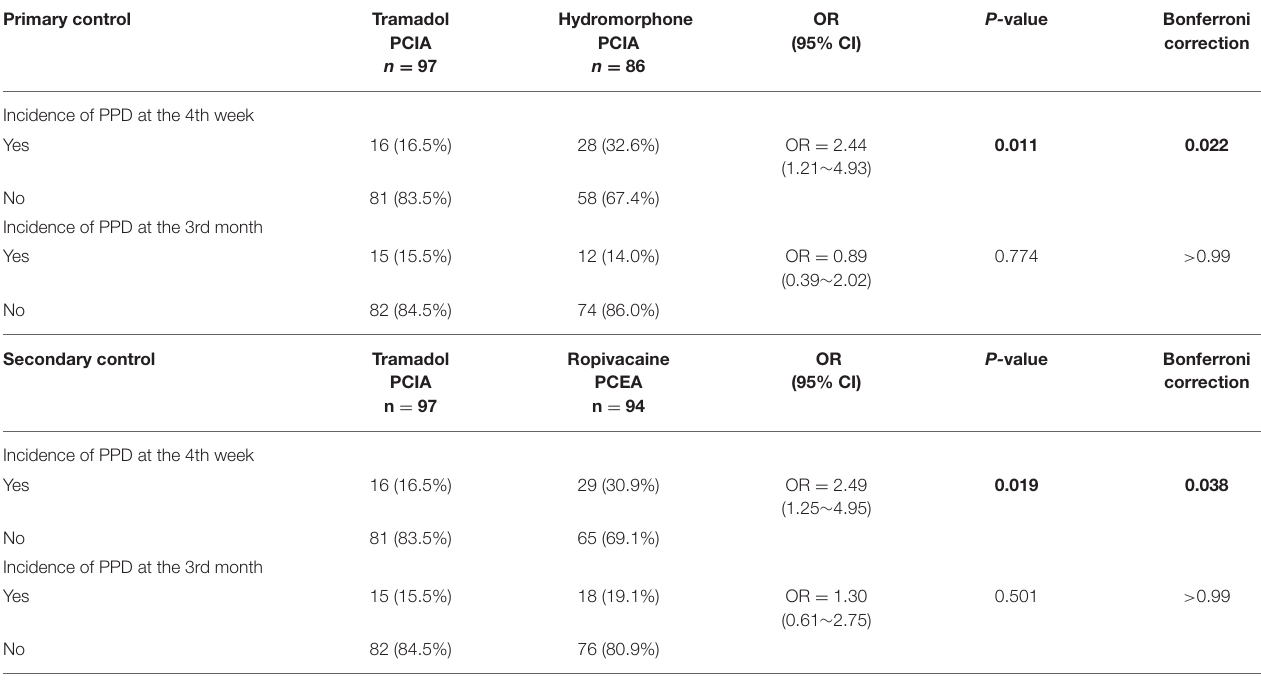
TABLE 3 | Subgroup analysis comparing the incidence PPD in the tramadol group with those in primary and secondary control